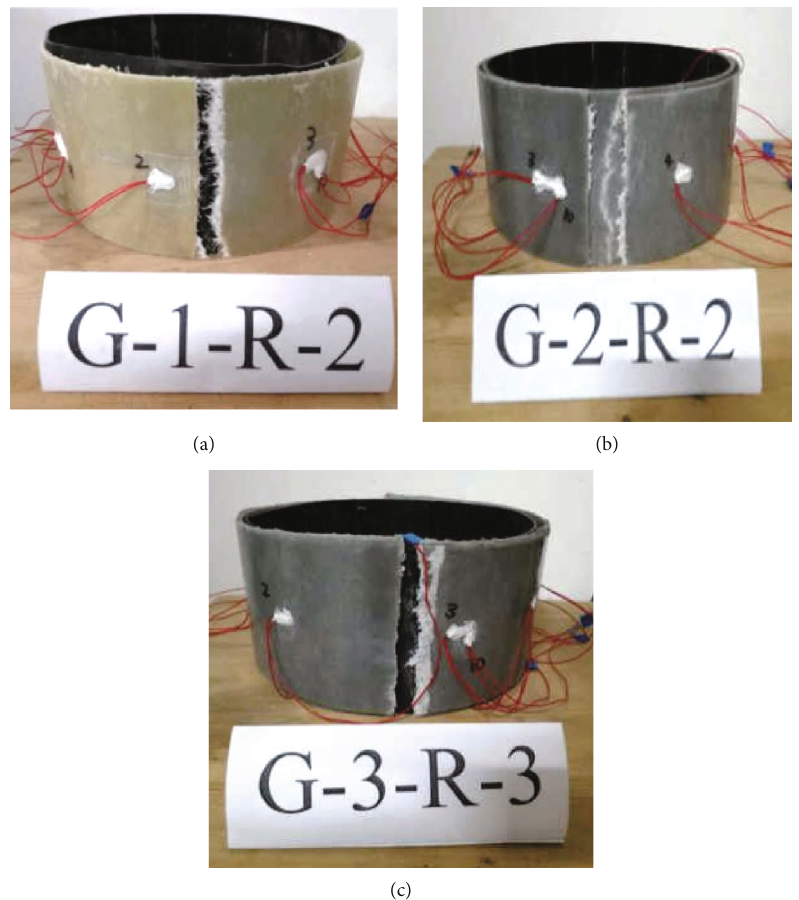
Figure 13: Failure modes of 1-layer rubber belt test